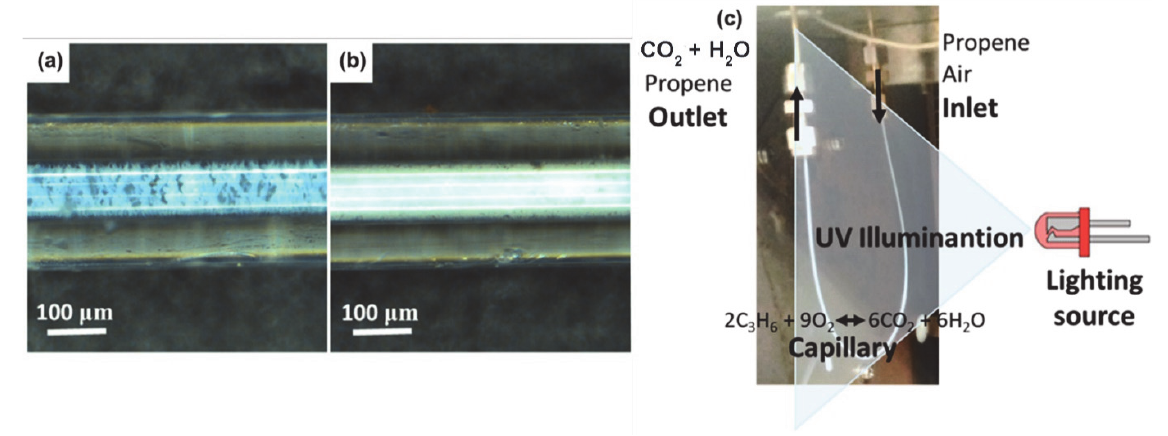
Figure 6. Microscope images of the different filled capillaries prepared in this study: ( a ) Cap. P25/F- 127; ( b ) Cap. P25. ( c ) Illustration of the experimental setup used for the photocatalytic oxidation of VOCs. Adapted from Ref. [101].).